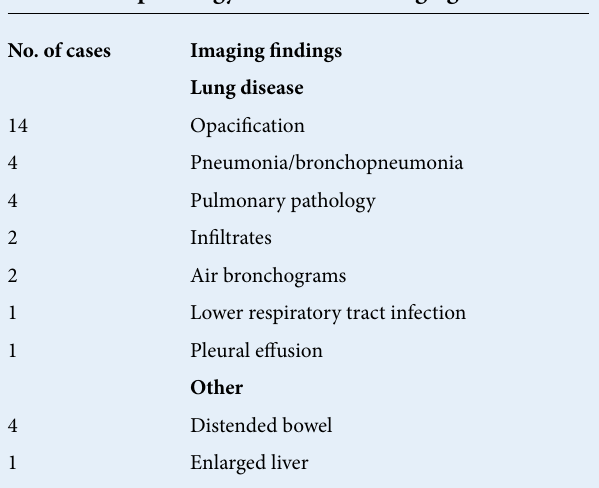
Table 2. Imaging findings for 32 non-autopsied cases where pathology was found on imaging